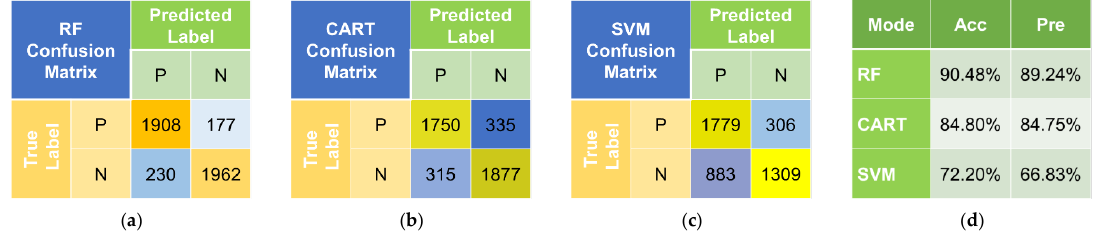
Figure 7. Assessment accuracy comparison and performance analysis of different models. ( a ) RF model; ( b ) CART model; ( c ) SVM model; ( d ) accuracy indices.